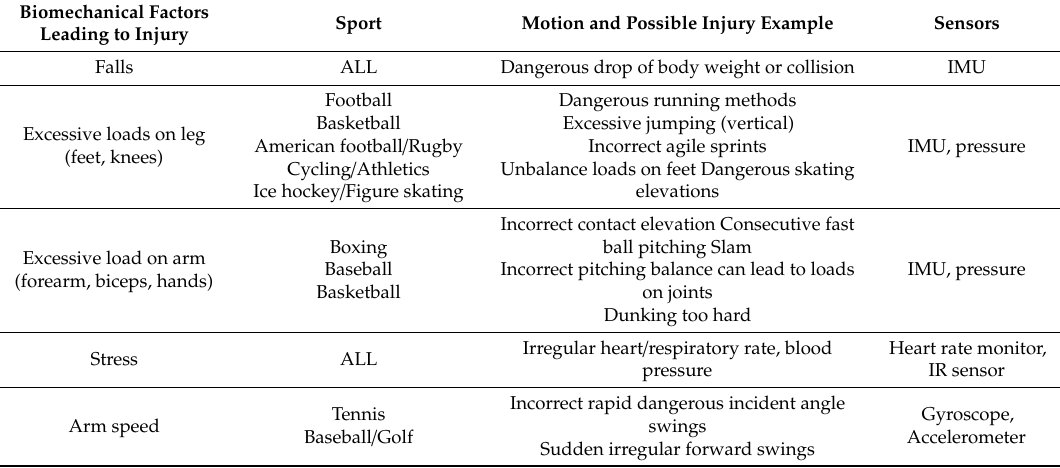
Table 8. Example of potential incorrect maneuvers that leads to injury which can be monitored via sensors for di ff erent